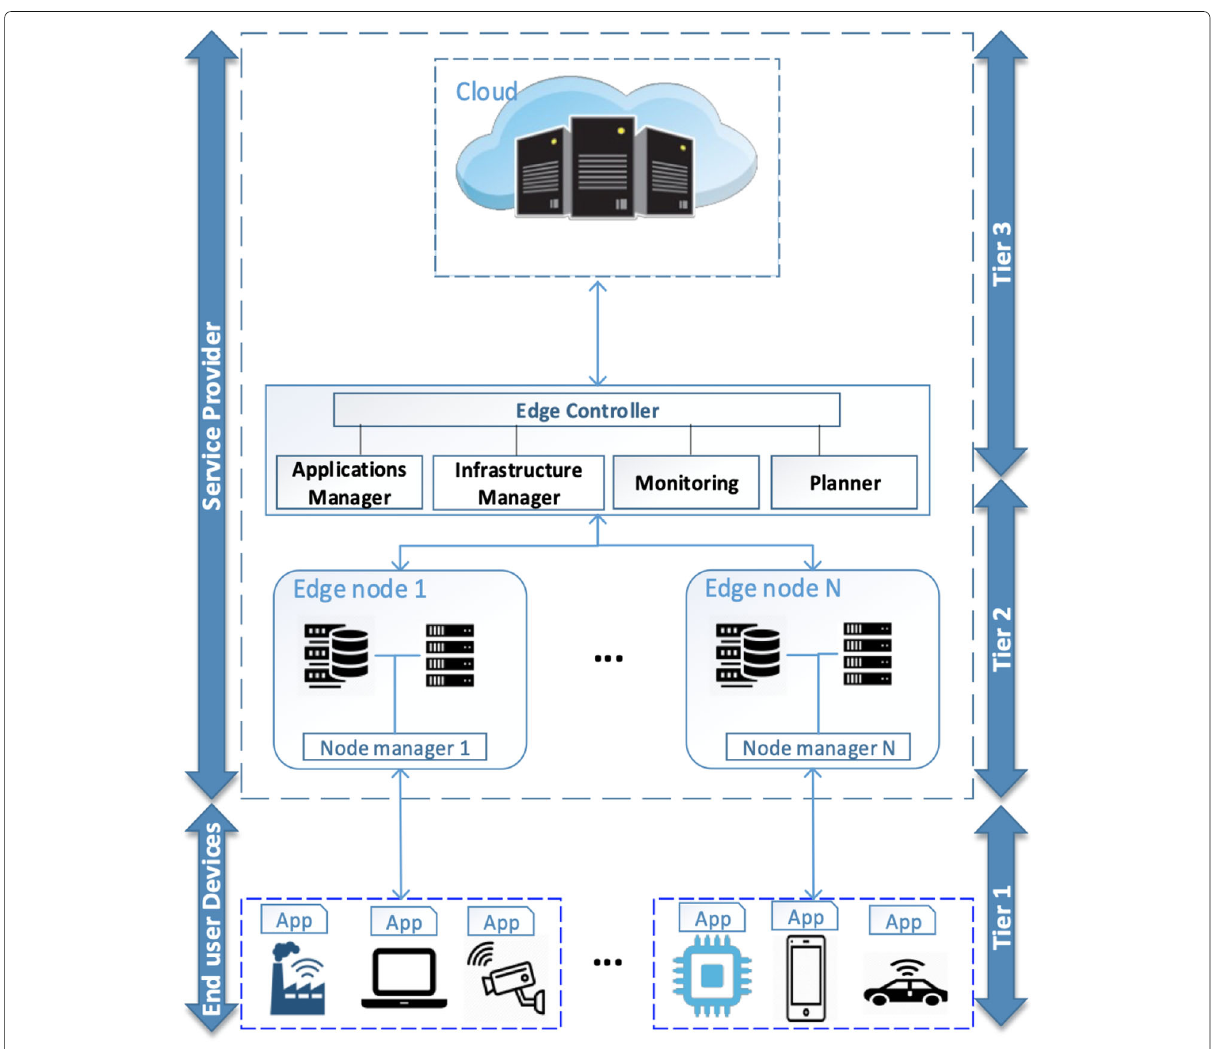
Fig. 1 An overview of Edge-Cloud